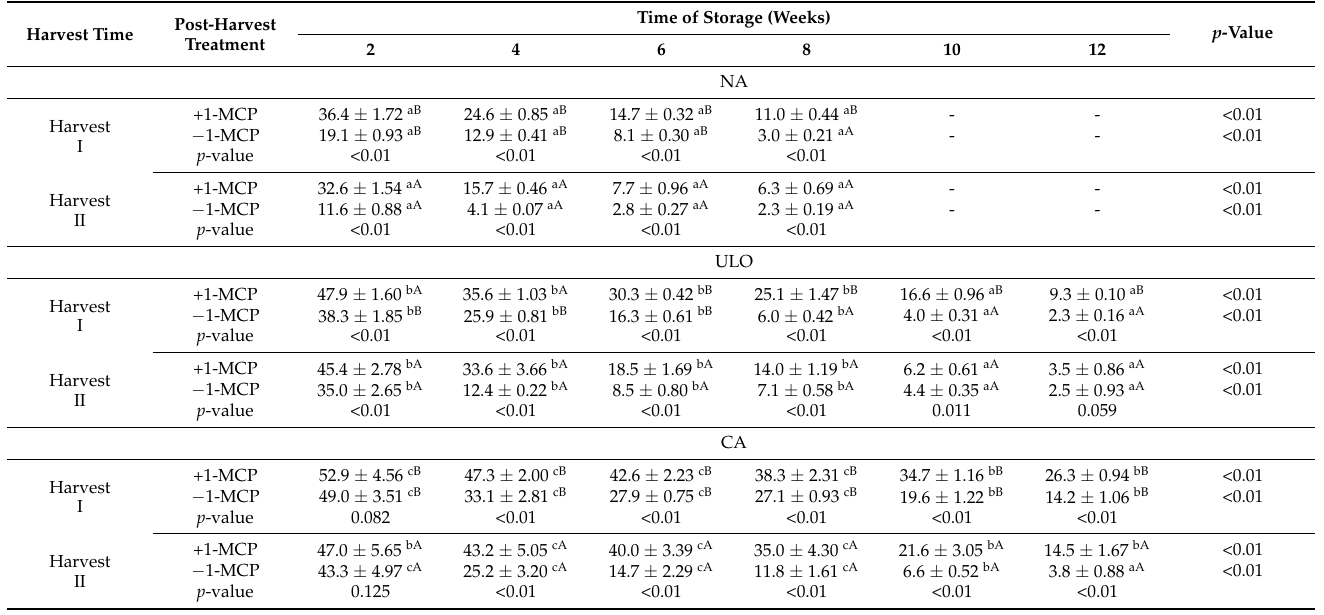
Table 3. Changes of firmness [N] measured in ‘Ananasnaya’ mini kiwi fruit in the post-harvest